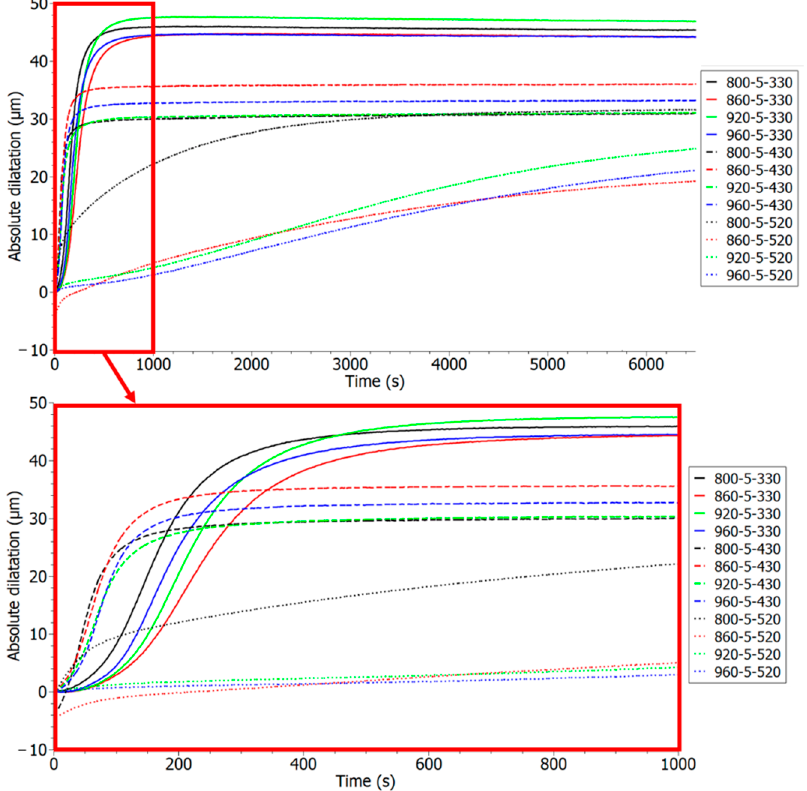
Figure 6. Absolute dilatation of the samples during isothermal bainite transformation.